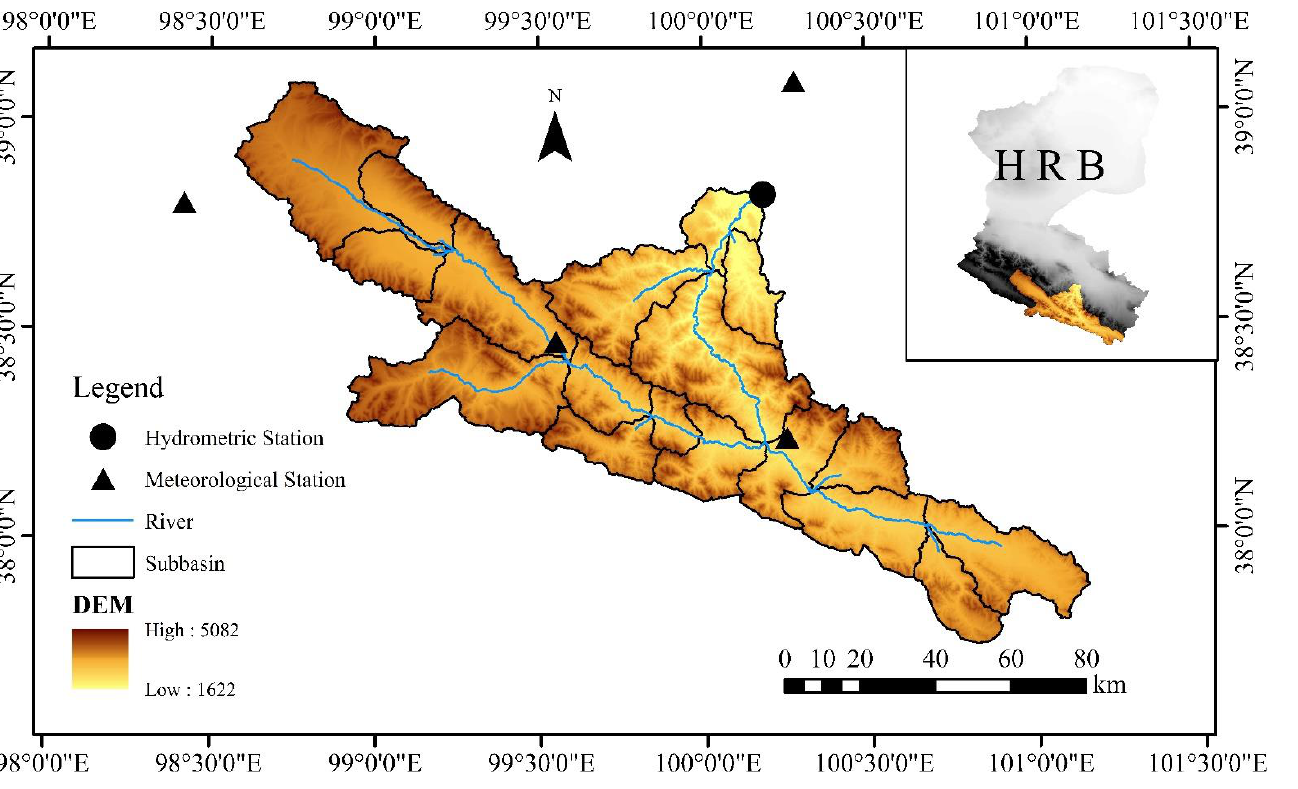
Figure 1. Digital elevation model (DEM), hydrometric and meteorological stations of the Upper Heihe River Basin (UHRB).